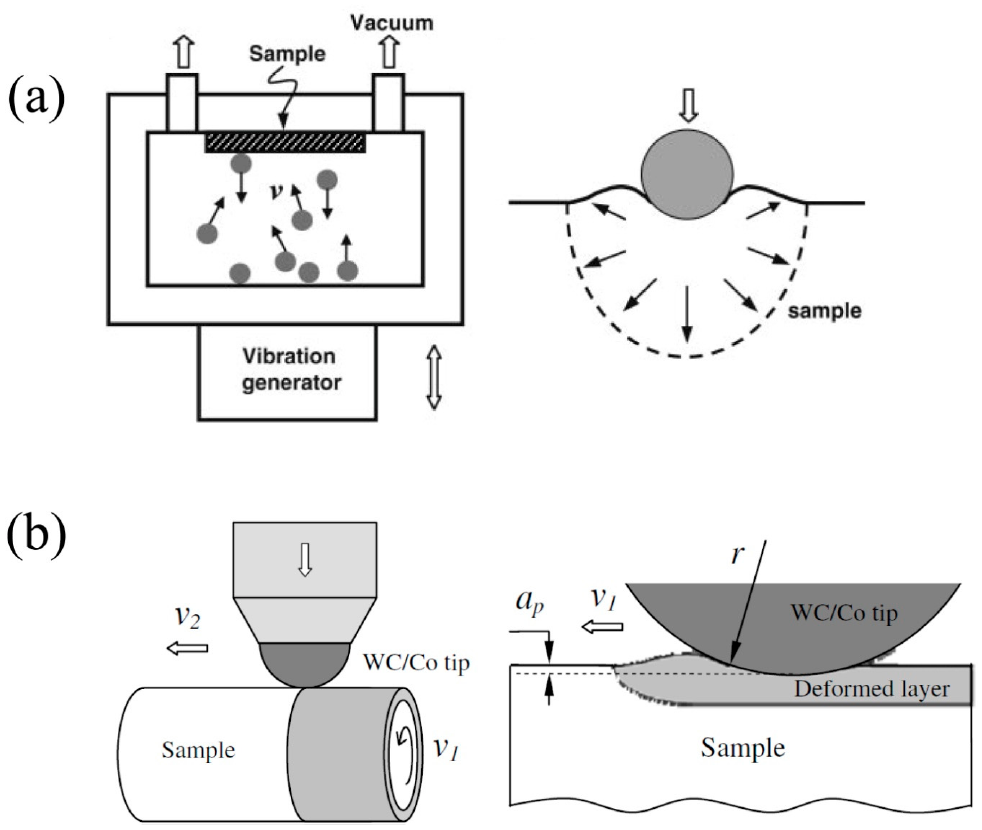
Figure 4. Schematic illustrations of SMAT and SMGT techniques. Adapted from [38] and [41].